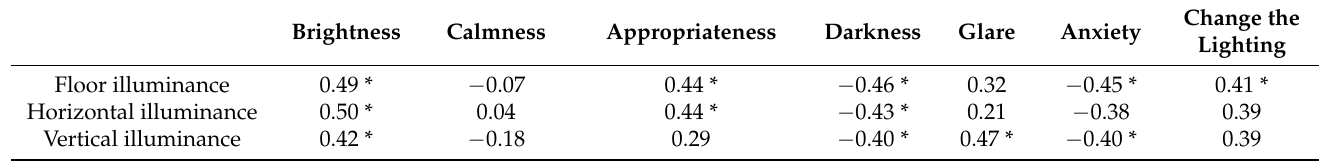
Table 5. Correlation between physical quantities and impression evaluation items (* p < 0.05). Brightness Calmness Appropriateness Darkness Glare Anxiety